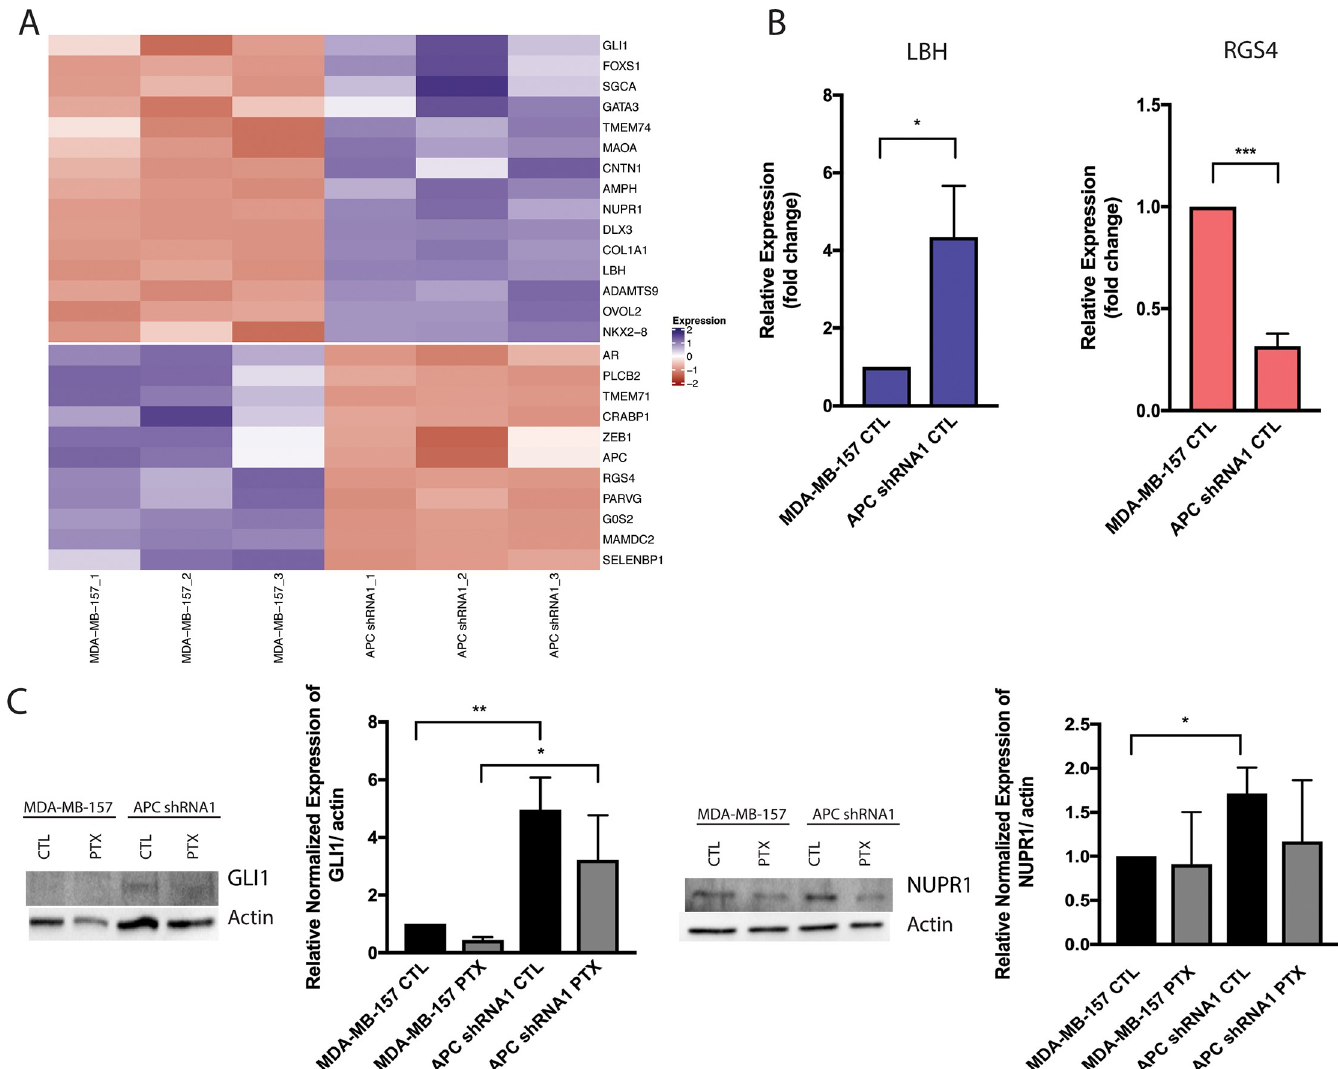
Fig 5. RNA sequencing and validation of APC shRNA1 cells compared to parental controls. (A) Hierarchical clustering and heat map of significantly differentially expressed genes associated with the cell cycle. Input data are the normalized expression values. The values in blue are up-regulated and those in red are down-regulated. (B) Real-time RT-PCR analysis for LBH and RGS4 in MDA-MB-157 and APC shRNA1 cells. Data were initially normalized by amount of GAPDH mRNA, and then further normalized to the parental cells. Data (AVG +/- SEM) depict changes in expression between parental and APC shRNA1 cells, with average of parental (n = 3) set to 1 and average of APC shRNA1 representing fold-change. (C) Western blot analysis for GLI1 and NUPR1 in MDA-MB-157 and APC shRNA1 cells with Actin as a loading control. Bar graph representation of protein quantification (n = 3 for GLI1 and n = 4 for NUPR1) in untreated and PTX treated cells. Analysis indicated that loss of APC increased GLI1 and NUPR1 in untreated cells. � p < 0.05, �� p < 0.01 as compared to parental